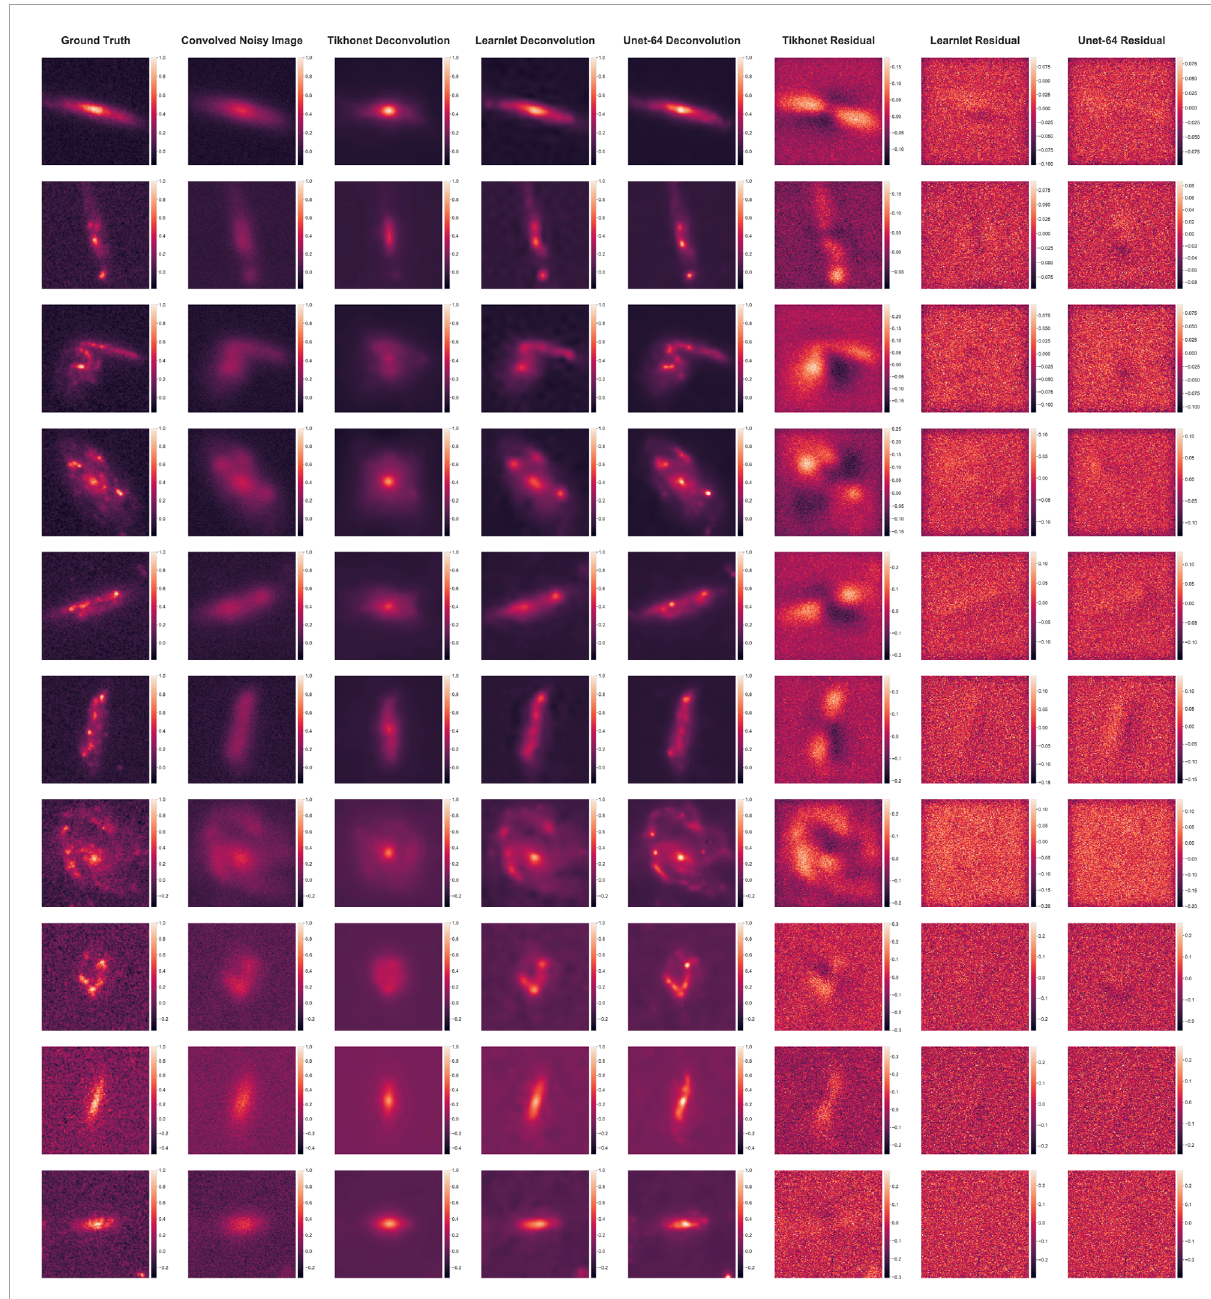
FIGURE 4 Ten examples of deconvolved images in decreasing order of SNR along with the corresponding residuals. Unet-64 results in the best reconstructions with the cleanest residuals.